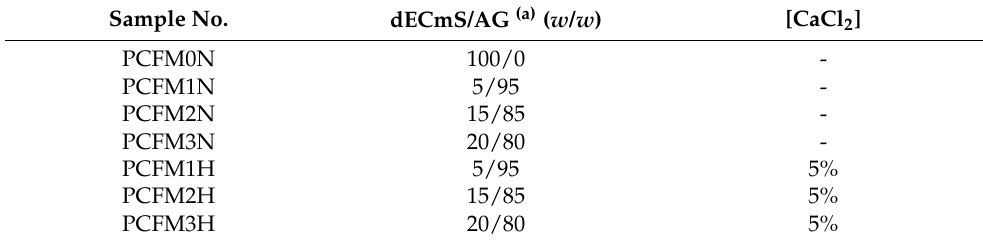
Table 1. Preparation of new composite foam materials with decellularized elastic cartilage microscaffolds.